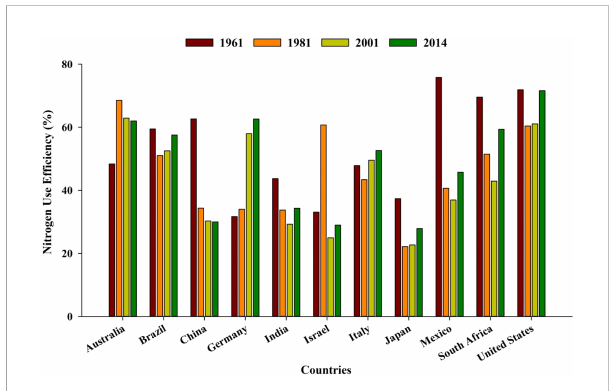
FIGURE 3 Average nitrogen use ef fi ciency in different countries over the years (source: Lassaletta et al., 2014). https://ourworldindata.org/fertilizers